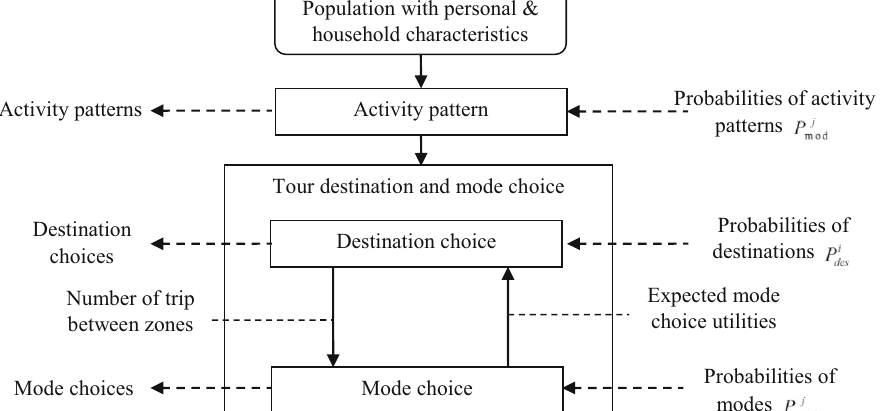
Fig. 2 Structure of developed activity-based TDF modeling procedure